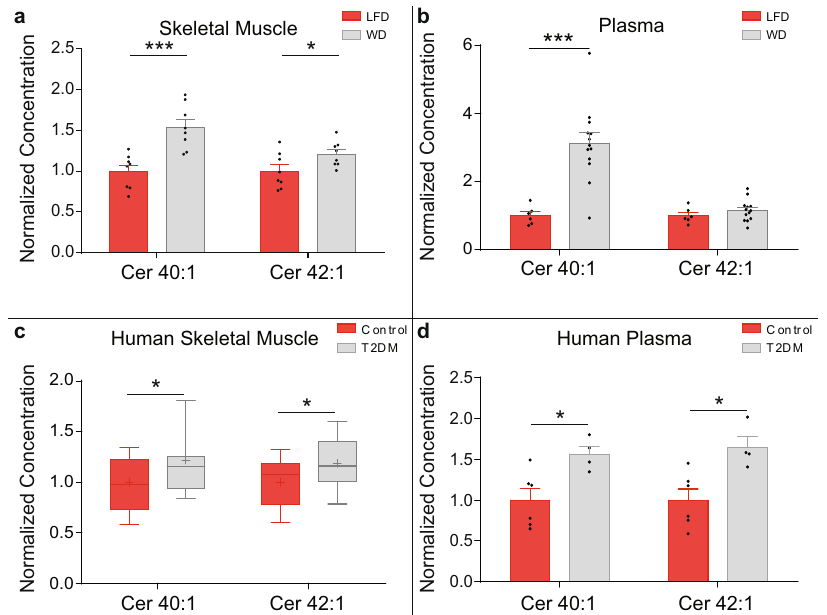
Fig. 3 Long-chain ceramides are enriched in murine and human skeletal muscle during metabolic disease. a Ceramide (Cer) 40:1 and Cer 42:1 in soleus muscle of low-fat diet (LFD) (red) and western diet (WD) (grey) fed mice ( n = 8; two-tailed Student ’ s t test; Cer 40:1 P = 0.00056, Cer 42:1 P = 0.045). b Cer 40:1 and Cer 42:1 in plasma of LFD (red) and WD (grey) fed mice (LFD n = 6, WD n = 13; two-tailed Student ’ s t test; Cer 40:1 P = 0.00031). c Cer 40:1 and Cer 42:1 in skeletal muscle biopsies from patients with type 2 diabetes (T2D) (grey) and controls (red) (control n = 52, T2D n = 21; two-tailed Student ’ s t test; Cer 40:1 P = 0.033, Cer 42:1 P = 0.017). d Cer 40:1 and Cer 42:1 in blood plasma from patients with T2D (grey) and controls (red) (control n = 6, T2D n = 4; two-tailed Student ’ s t test; Cer 40:1 P = 0.0118, Cer 42:1 P = 0.012). * P ≤ 0.05, ** P < 0.01, *** P < 0.001, **** P < 0.0001. Data in bar charts are expressed as mean ± SEM with individual data points. Box and whisker plots show 25th to 75th percentile (box) min to max (whiskers), mean ( + ) and median ( − ). Source data are provided as a Source Data fi